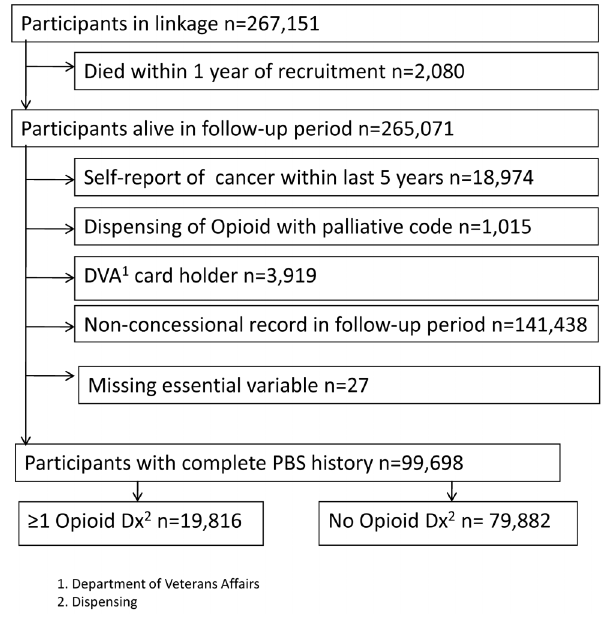
Figure 1. Participant flow according to inclusion and exclu- sions rules in this